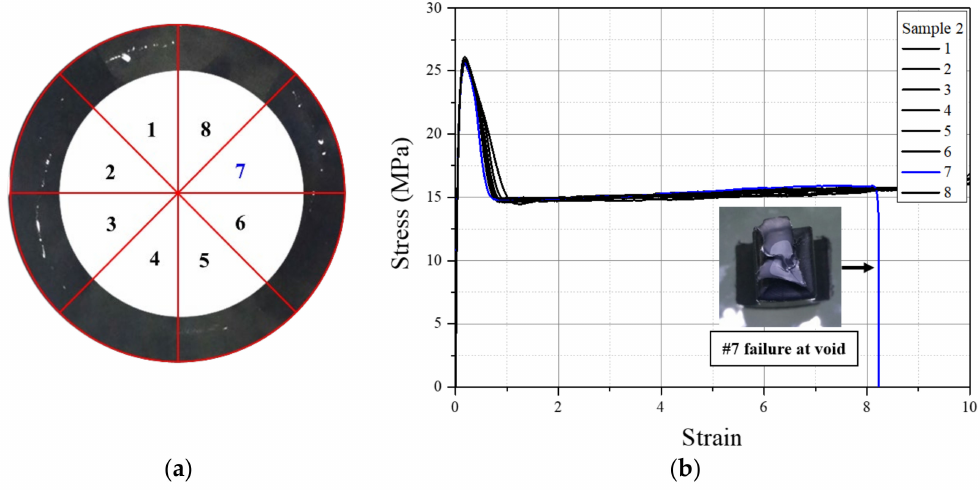
Figure 15. The 12 mm thick tensile specimens from pipe sample 2. ( a ) The eight sector locations, and ( b ) tensile stress–strain curve of each